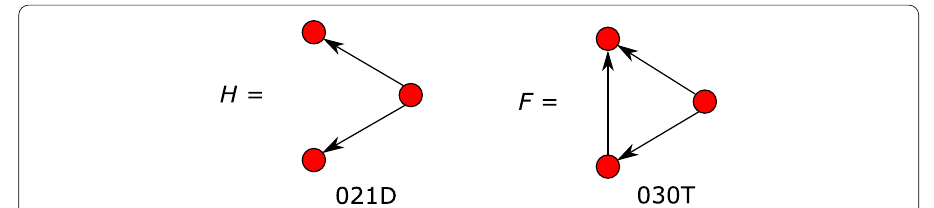
Fig. 2 Motif examples. F , the transitive triangle (triad 030T) is not a special case of H , the out-star (triad 021D), when considered as motifs (or triad census classes): they are distinct induced subgraphs of three nodes. However, when considered as ERGM configurations, since H is a subgraph (but not an induced subgraph) of F (the transitive triangle is formed by “closing” the out-star with an additional arc), in their corresponding statistics both F and H are counted for an occurrence of